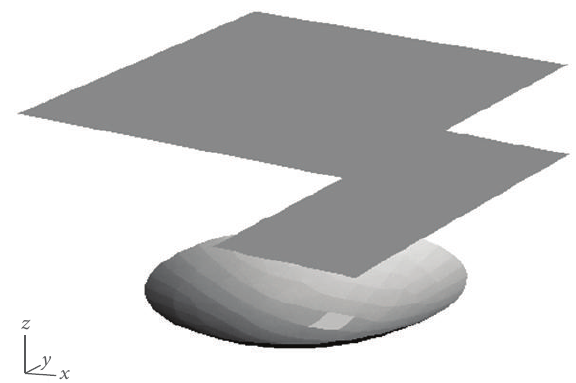
Figure 30: Geometrical model of an armored vehicle.